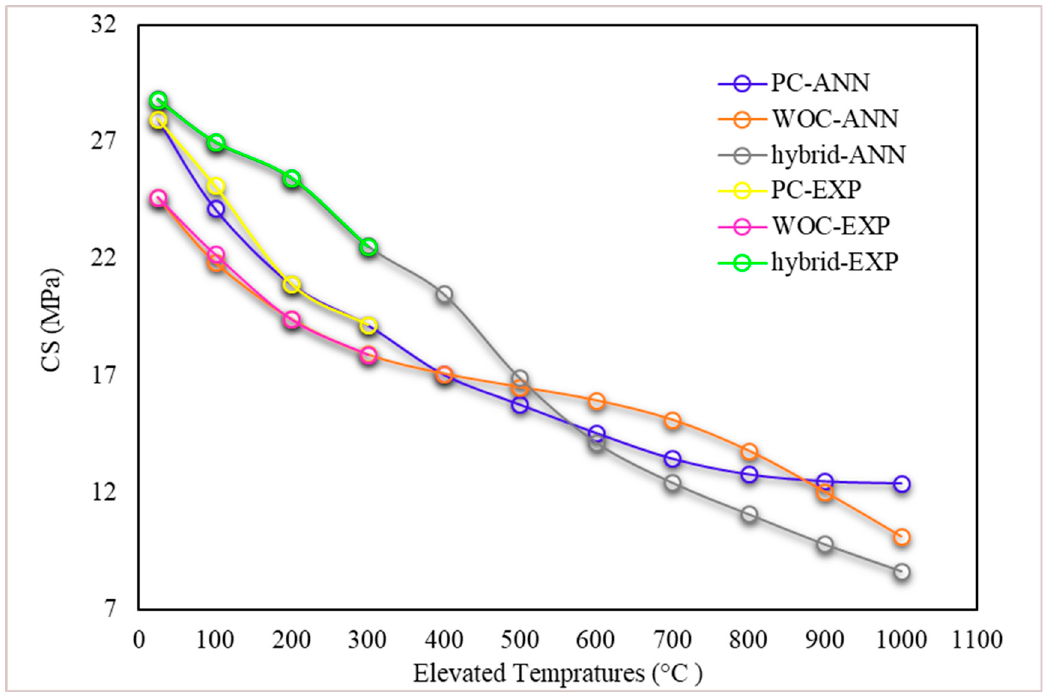
Figure 22. Effect of Elevated Temperatures on Concrete Compressive Strength at 28 Days (MPa).